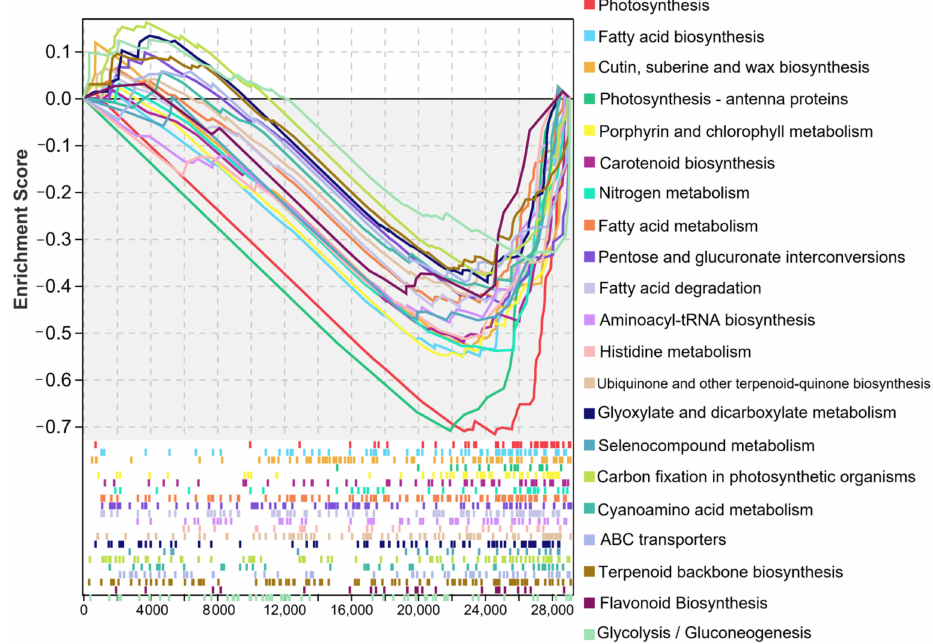
Figure 11. The metabolic pathways significantly enriched in